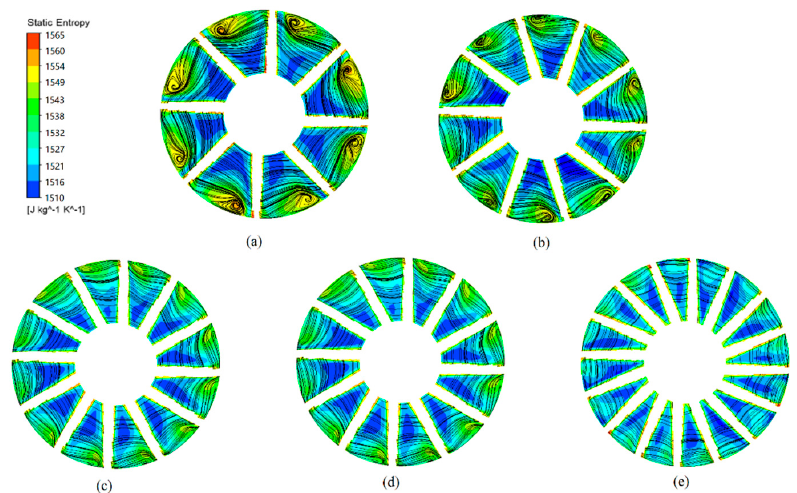
Figure 14. Entropy distribution at outlet with surface streamlines of air: ( a ) solidity 7.96; ( b ) solidity 9.95; ( c ) solidity 11.94; ( d ) solidity 13.93; ( e ) solidity